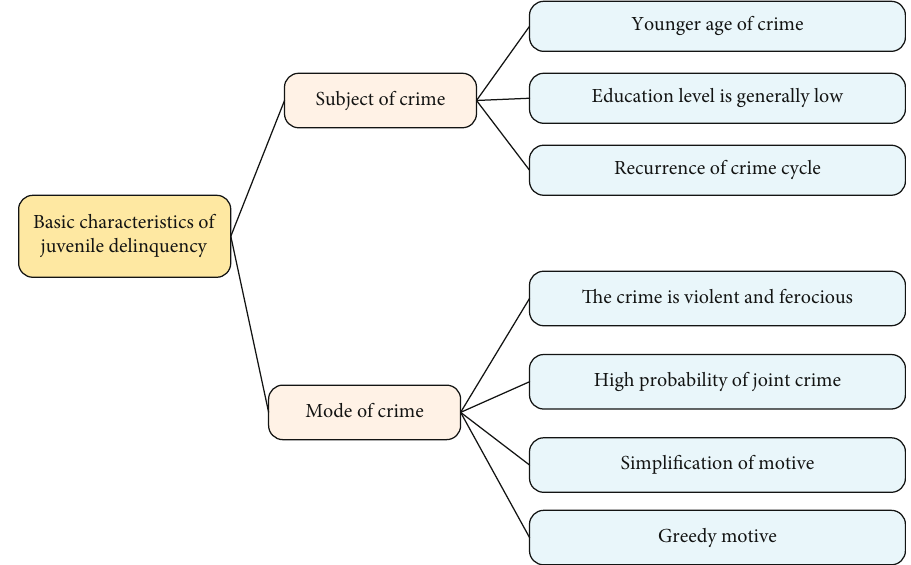
Figure 8: Basic characteristics of juvenile